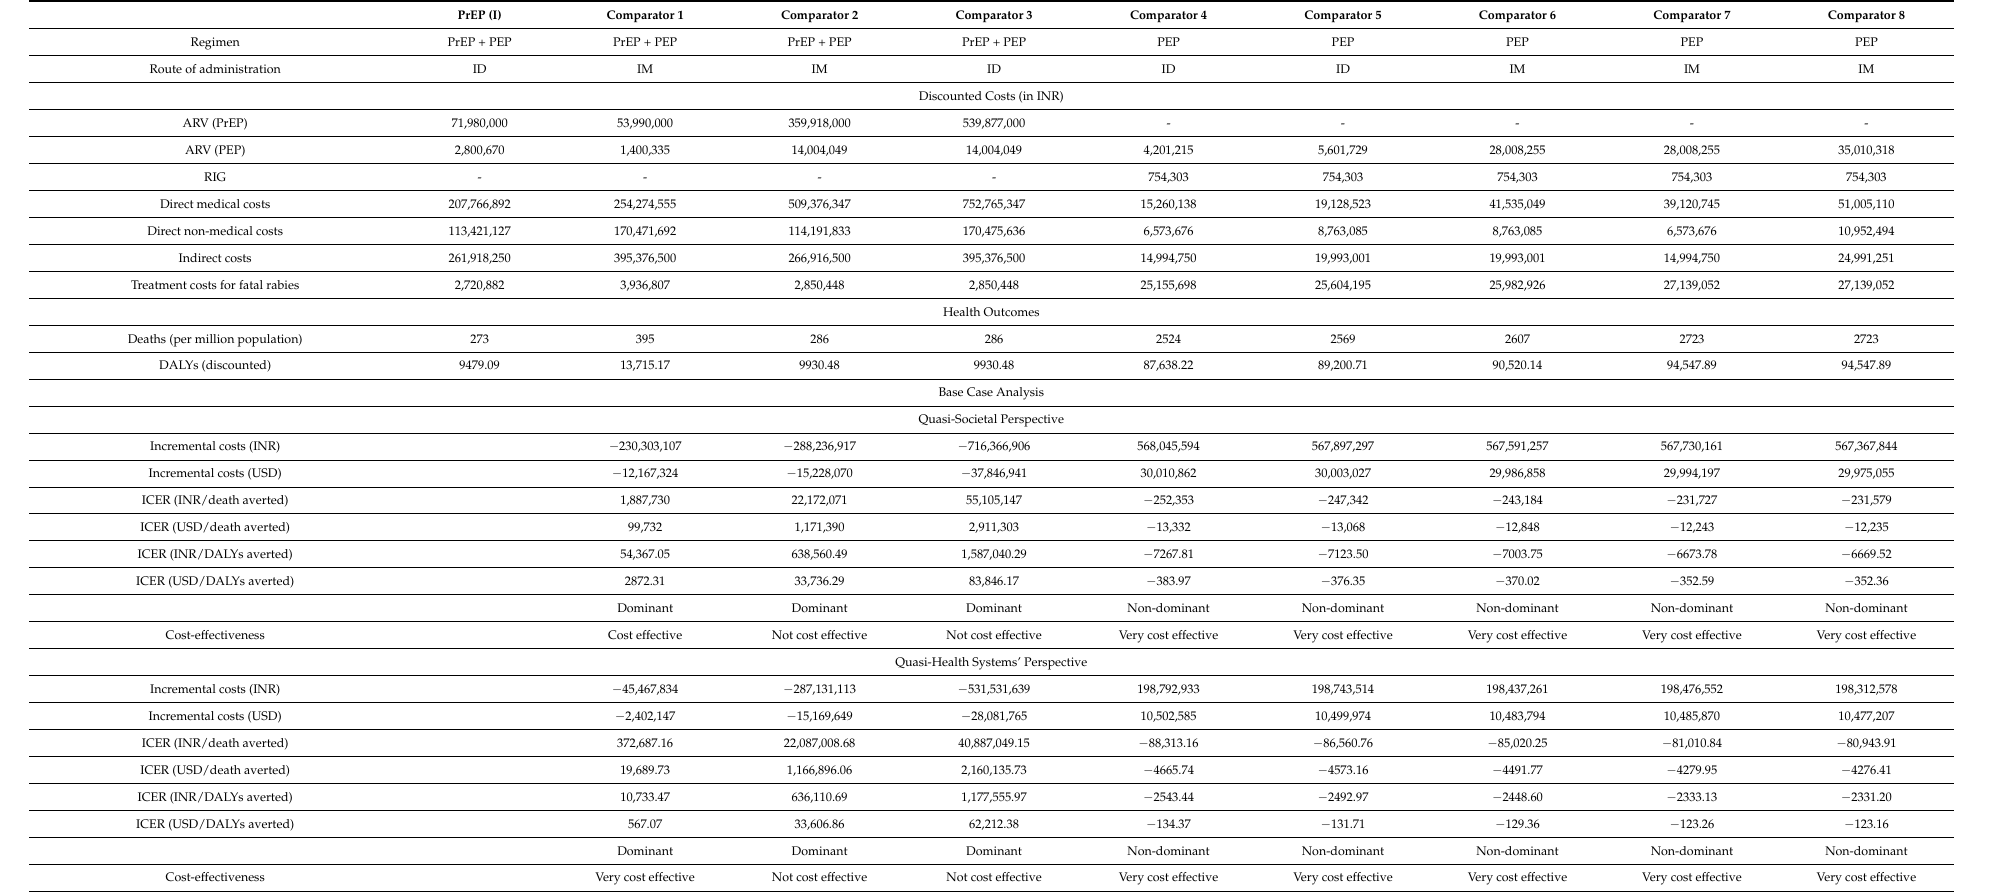
Table 3. Results of cost-effectiveness